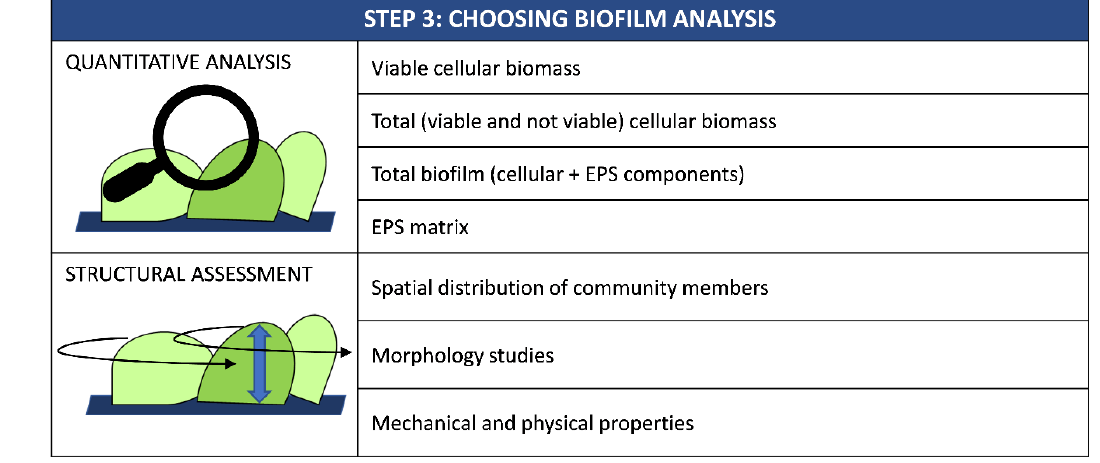
Figure 3. Scheme representing the third step in the experimental procedure for testing new anti-